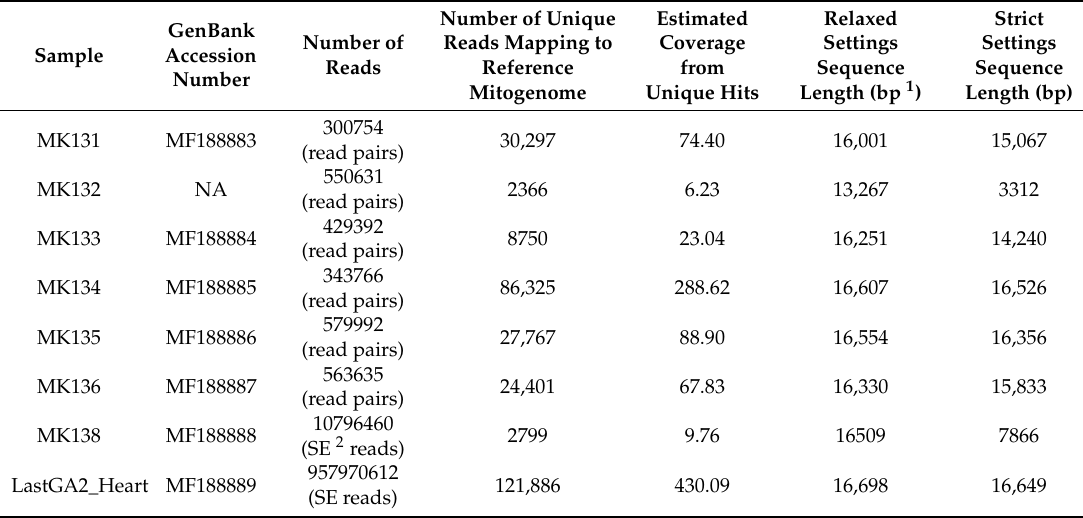
Table 2. Read processing results for all